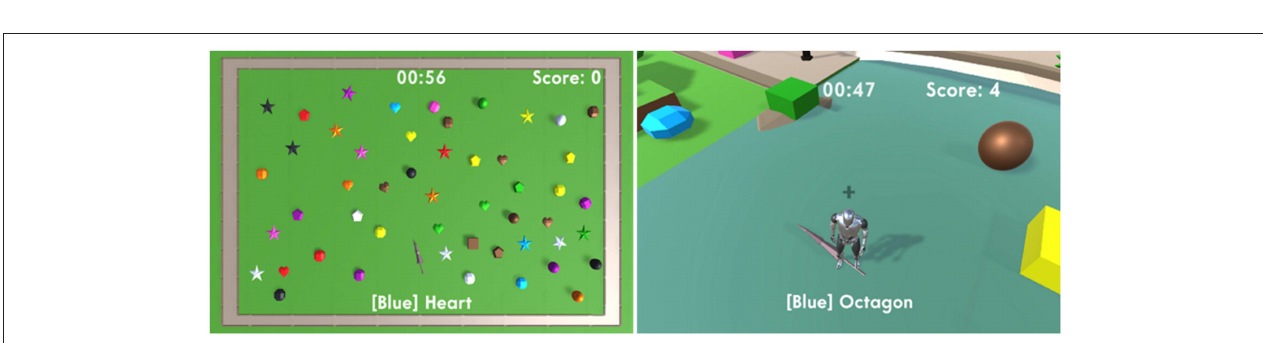
FIGURE 4 | The target details technique. A large preview hint of the target shape to find in the top-down game ( left ), and in the third-person game ( right ).